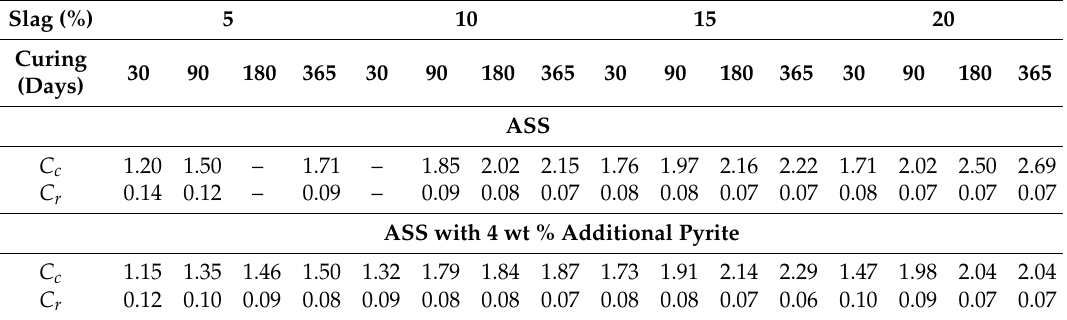
Table 3. Compression properties ( C c , C r ) of alkali-activated slag treated ASS.